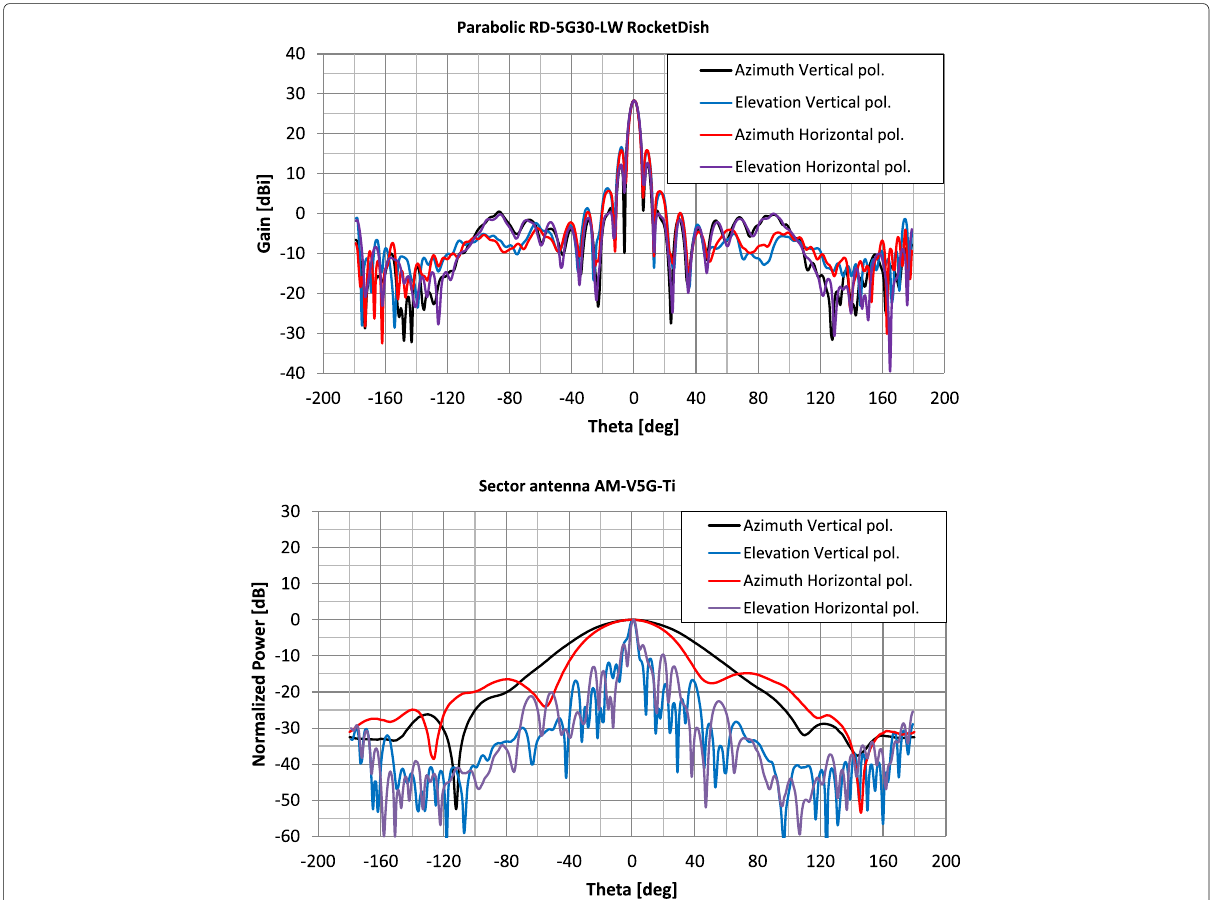
Fig. 4 Parabolic and sector antennas rectangular radiation. Both E and H planes in the case of vertical and horizontal co-polarizations are